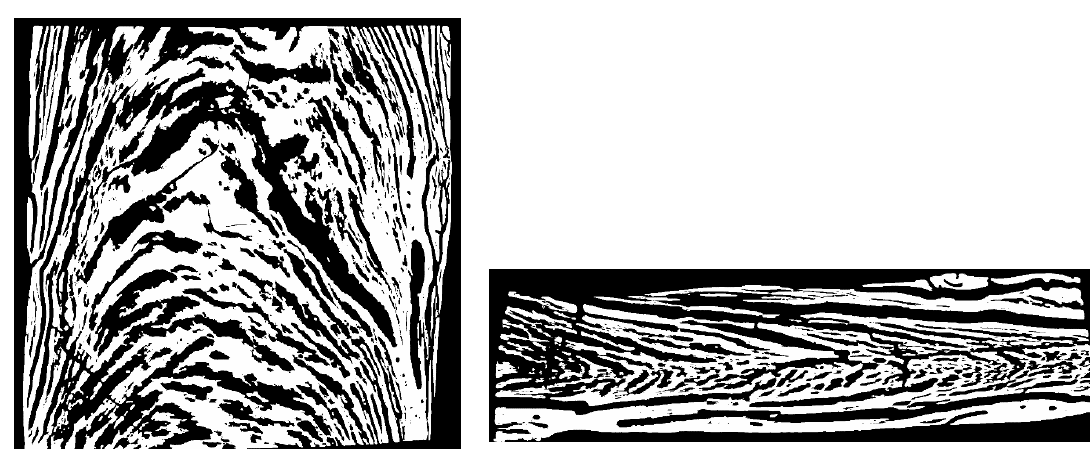
Figure 9. Microstructure of freeze-dried SPI extrudate, obtained with X-ray measurements. Sample was extruded at 50% ( w/w ) moisture content and material temperature of 124 °C before entering the cooling die. Top view ( left ) and side view ( right ) are displayed. Flow direction is directed from bottom to top for the top view and left to right for the side view.